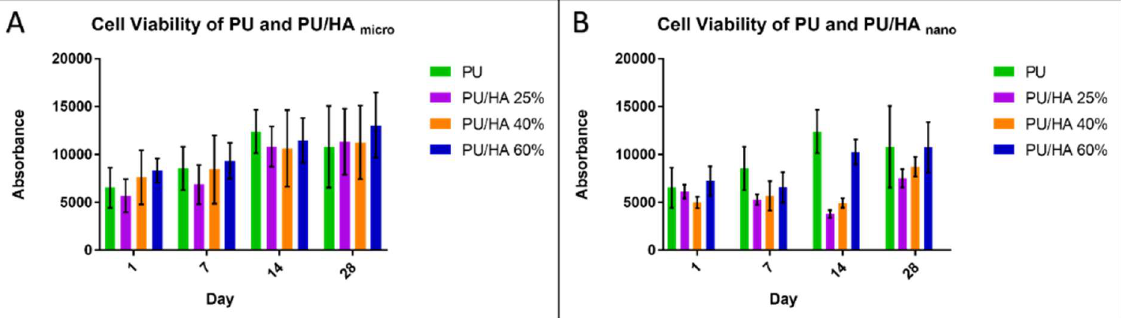
Figure 9. Alamar Blue cell viability; ( A ) for PU/HA micro group & ( B ) for PU/HA nano group. All scaffolds show good cell viability and biocompatibility.